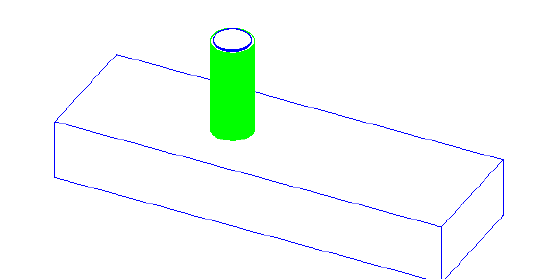
Figure 6. Microwave cavity of the Prolabo Synthewave TM